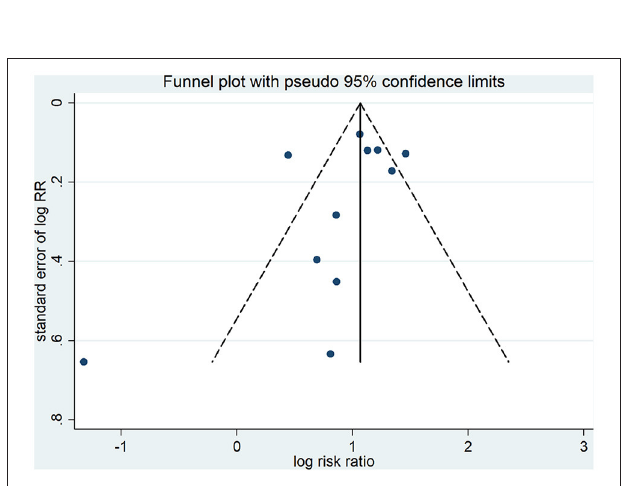
FIGURE 5 | Funnel plot for the assessment risk of publication